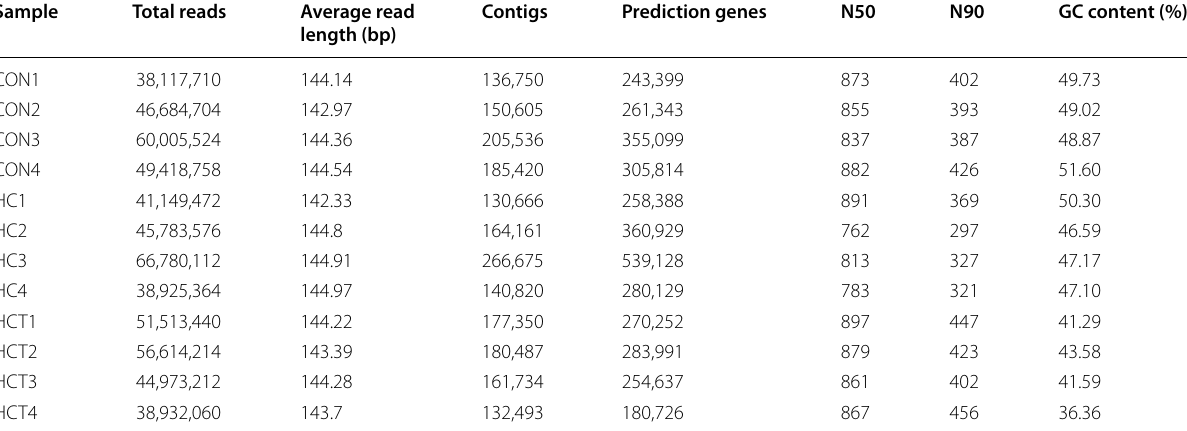
Table 2 Quantitative information and quality control of sequencing